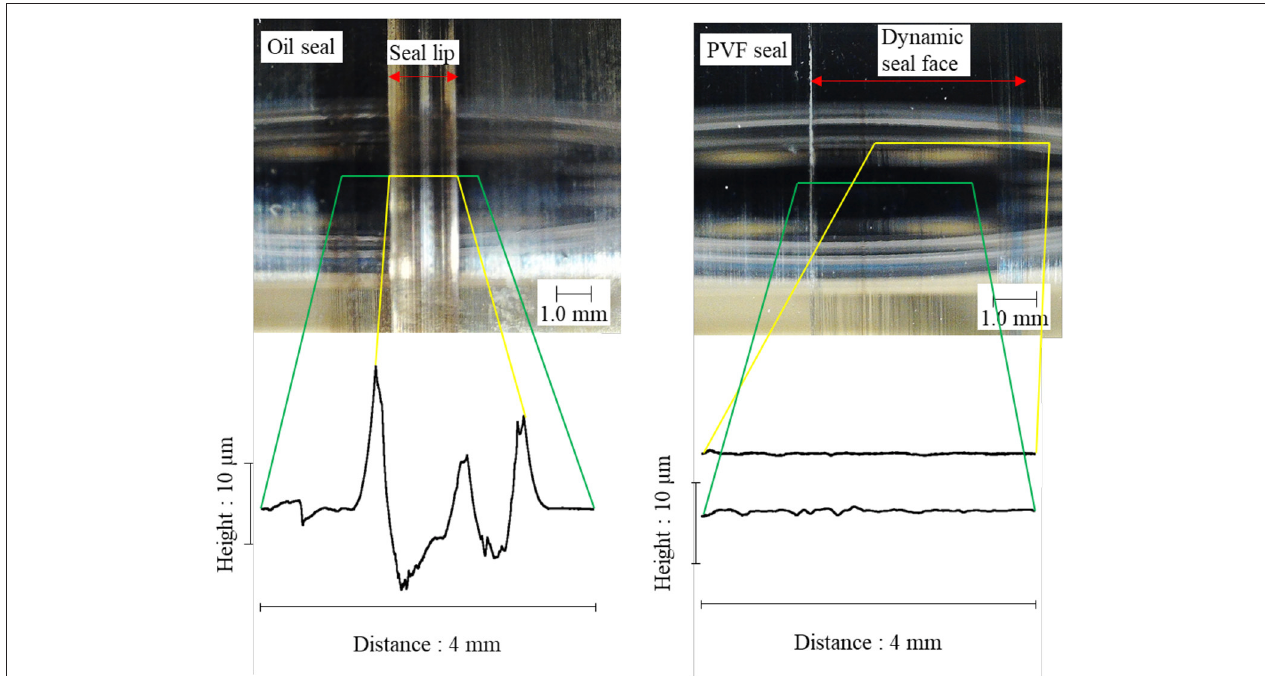
FIGURE 8 | Microscopy images and surface profiles of both rotating